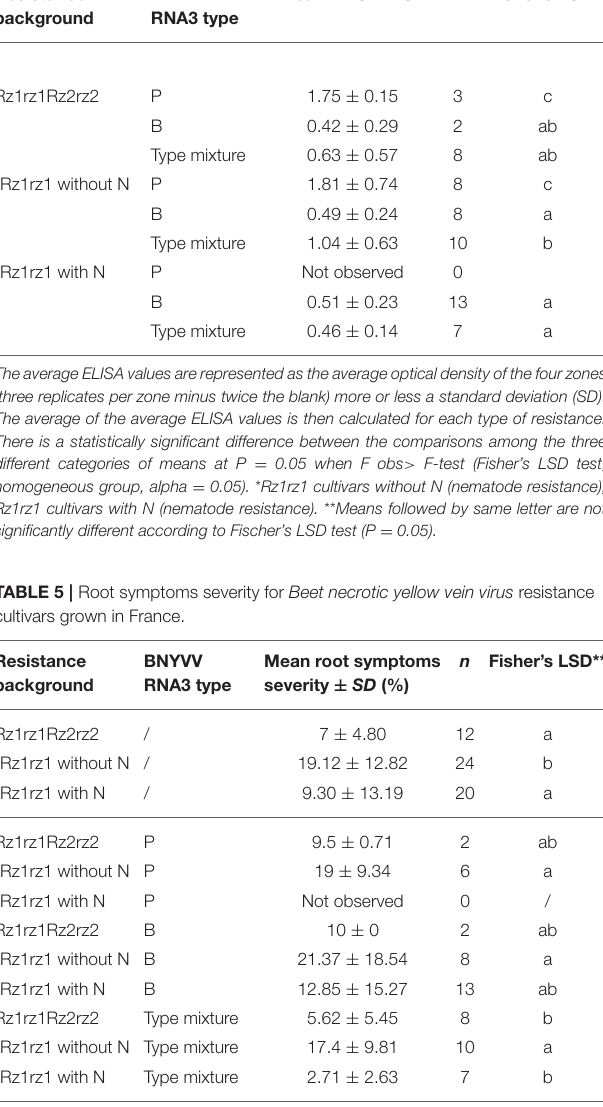
TABLE 4 | Enzyme linked immunosorbent assay (ELISA) values for Beet necrotic yellow vein virus resistance cultivars grown in France. Resistance background